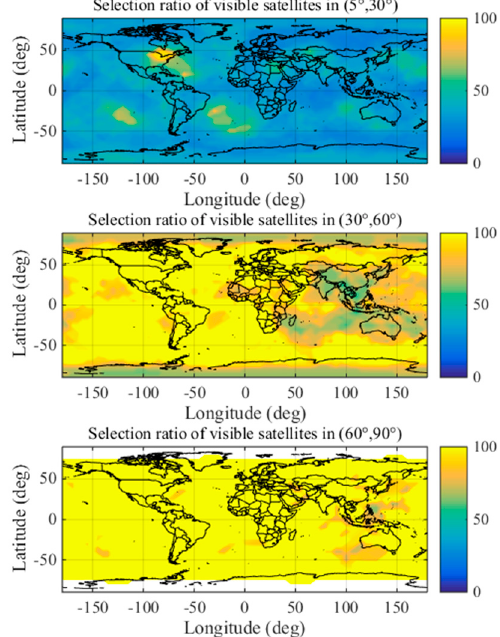
Figure 14. Global distribution ratios of the optimal satellite subsets with the brute method.